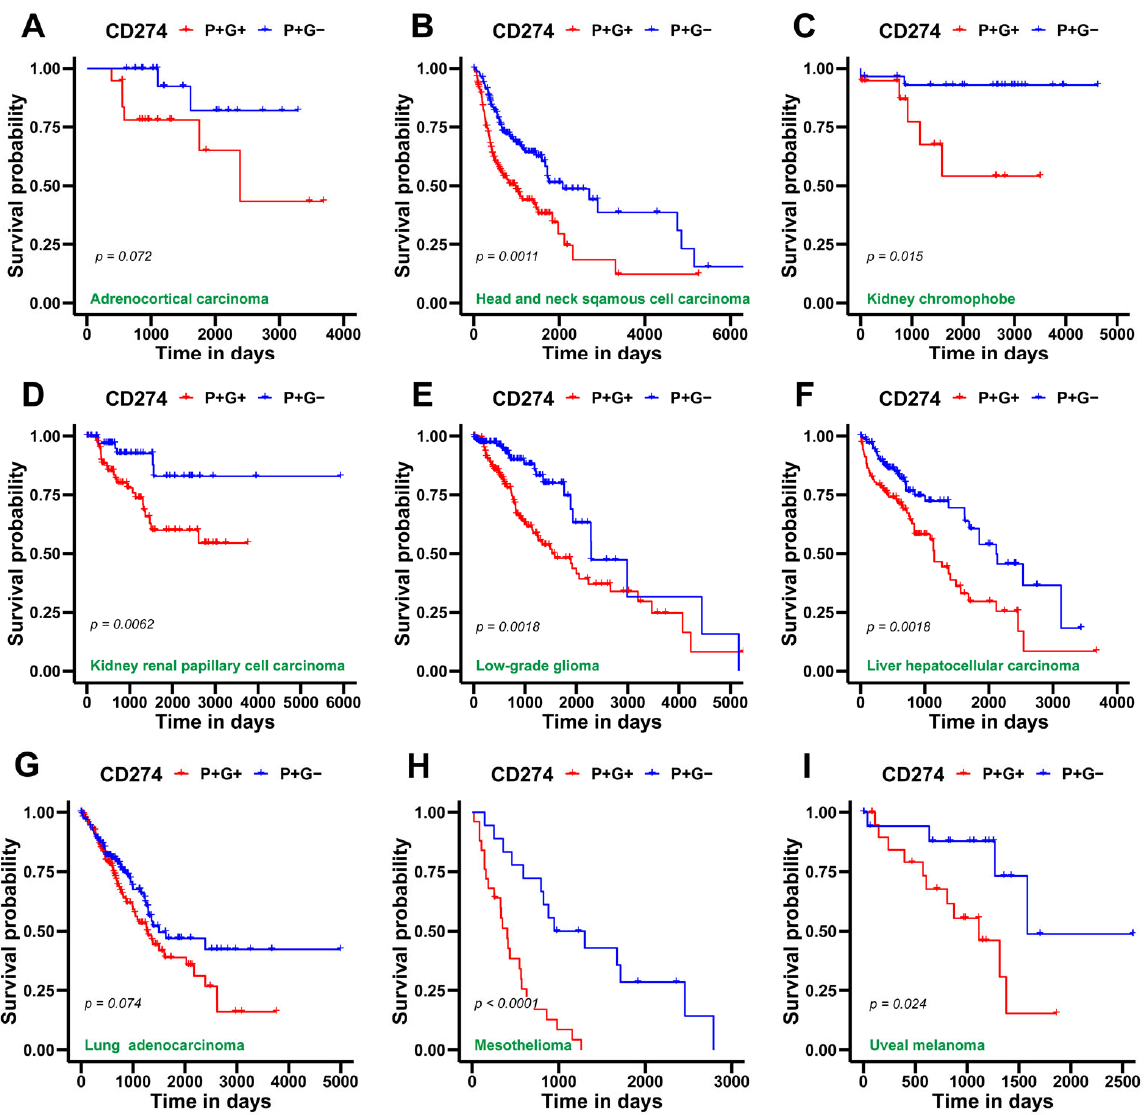
Figure 5. Survival analysis for CD274 gene expression and glycolysis gene signature in several TCGA patient cohorts across cancer types. ( A ) Kaplan–Meier curves associating overall survival (OS) with both a high CD274 gene expression and glycolysis signature (blue) and a high CD274 gene expression but a low glycolysis signature (red) in adenoid cystic carcinoma cohort from TCGA. Reported p-values are based on a log-rank test a indicating significant difference in survival. Same as ( A ) but for ( B ), head and neck squamous cell carcinoma, ( C ) kidney chromophobe, ( D ) kidney renal papillary cell carcinoma, ( E ) low ‐ grade glioma, ( F ) liver hepatocellular carcinoma, ( G ) lung adenocarcinoma, ( H ) mesothelioma, and ( I ) uveal melanoma.